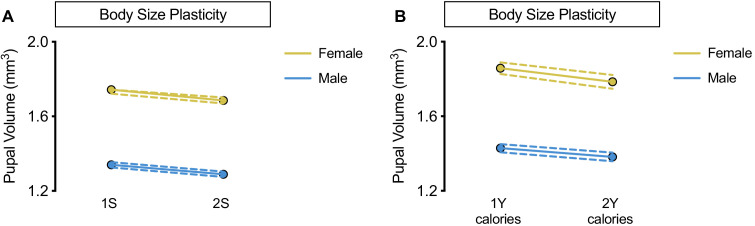
No sex-specific effect of altering dietary sugar concentration or calorie content.(A) Pupal volume was significantly decreased in both w1118 females and males reared on a diet with twice the sugar (2S) compared with genotype-matched females and males cultured on a diet with the sugar content of our regular diet (1S) (p<0.0001 and p=0.0002, respectively; two-way ANOVA followed by Tukey HSD test). The magnitude of the nutrient-dependent decrease in pupal volume was not different between females and males (sex:diet interaction p=0.6536; two-way ANOVA followed by Tukey HSD test). n = 117–133 pupae. (B) While pupal volume was significantly decreased in w1118 females and not males reared on a 2Y calorie-matched diet compared with genotype-matched females and males cultured on a 1Y calorie-matched diet (p=0.0039 and p=0.0662 respectively; two-way ANOVA followed by Tukey HSD test), there was no sex:diet interaction indicating that one sex was not more affected than the other (sex:diet interaction p=0.3698; two-way ANOVA followed by Tukey HSD test). n = 44–74 pupae. For body size plasticity graphs, filled circles indicate mean pupal volume, and dashed lines indicate 95% confidence interval.